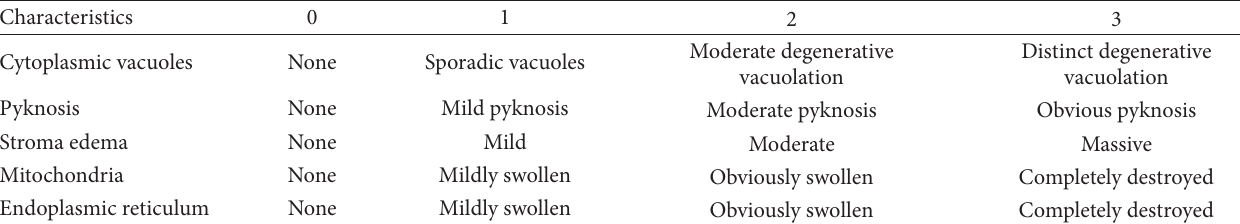
Table 2: Terminal villi were evaluated with respect to cytoplasmic vacuoles, pyknosis, and edema in the stroma, according to the semi- quantitative score based on the degree of ultrastructural